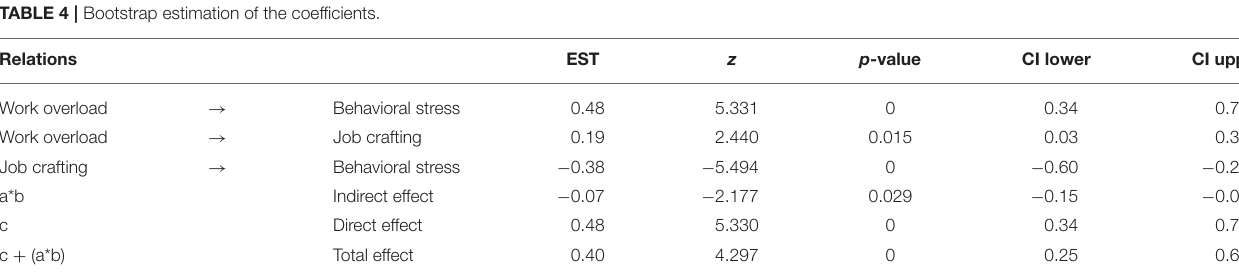
TABLE 4 | Bootstrap estimation of the